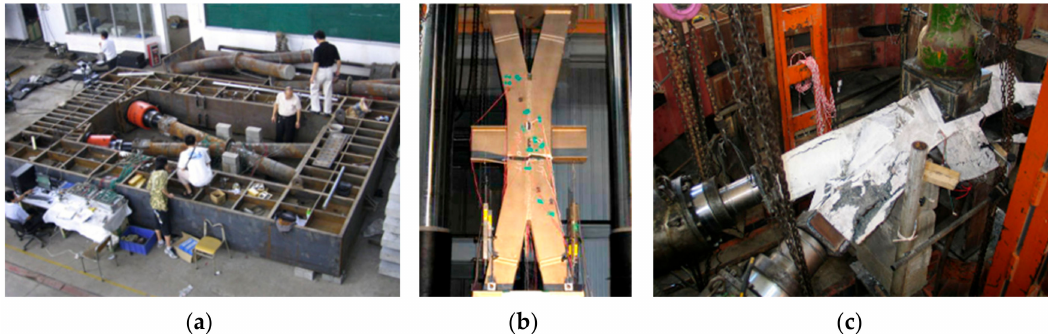
Figure 17. Research on diagrid nodes: ( a ) CFST joint, used with permission from Huang et al. [54]; ( b ) steel joint, used with permission from Kim et al. [55]; ( c ) concrete spatial joints, used with permission from Zhou et al.